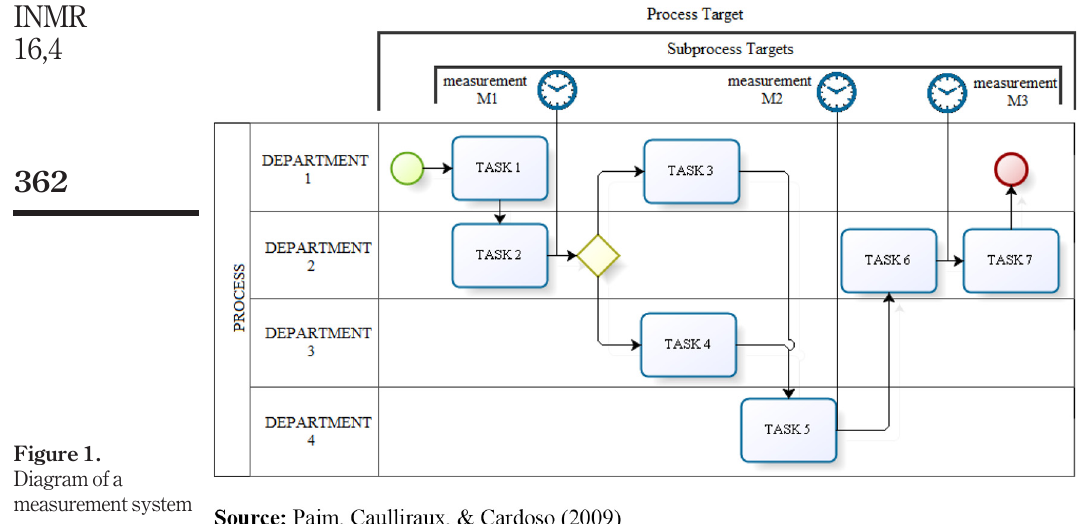
Figure 1. Diagram of a measurement